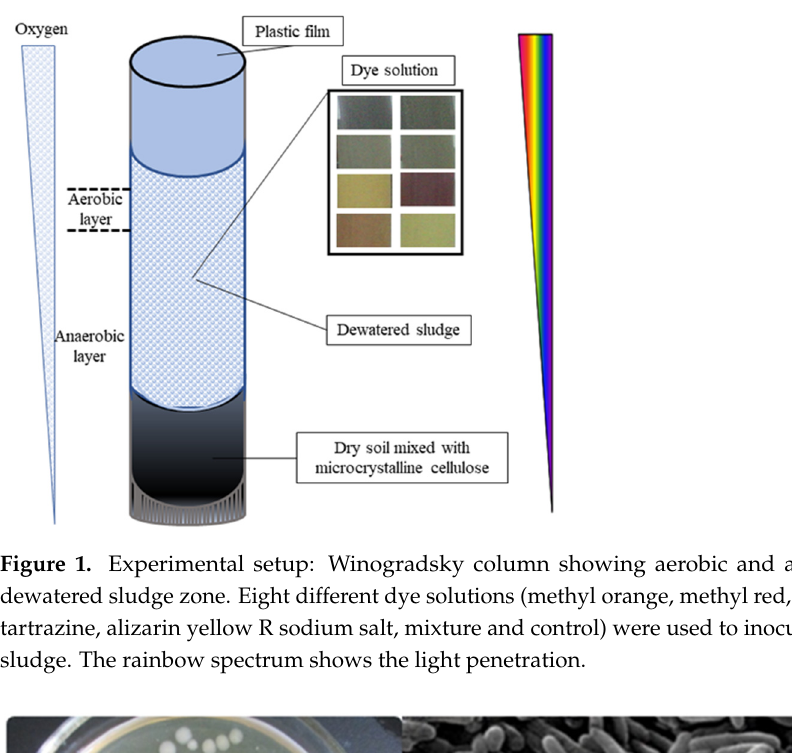
Figure 1. Experimental setup: Winogradsky column showing aerobic and anaerobic layers of de- watered sludge zone. Eight different dye solutions (methyl orange, methyl red, orange I, orange G, tartrazine, alizarin yellow R sodium salt, mixture and control) were used to inoculate the dewatered sludge. The rainbow spectrum shows the light penetration.